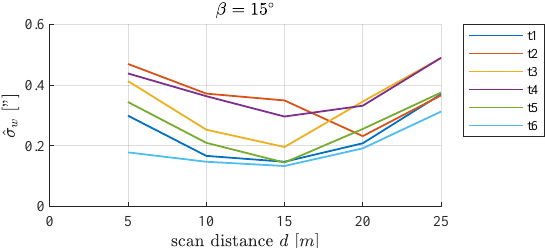
Figure 10. The standard deviations in angular direction ˆ σ w for different target designs in the close range, targets scanned with Leica ScanStation P20 and a resolution of 0.8 mm at 10 m.